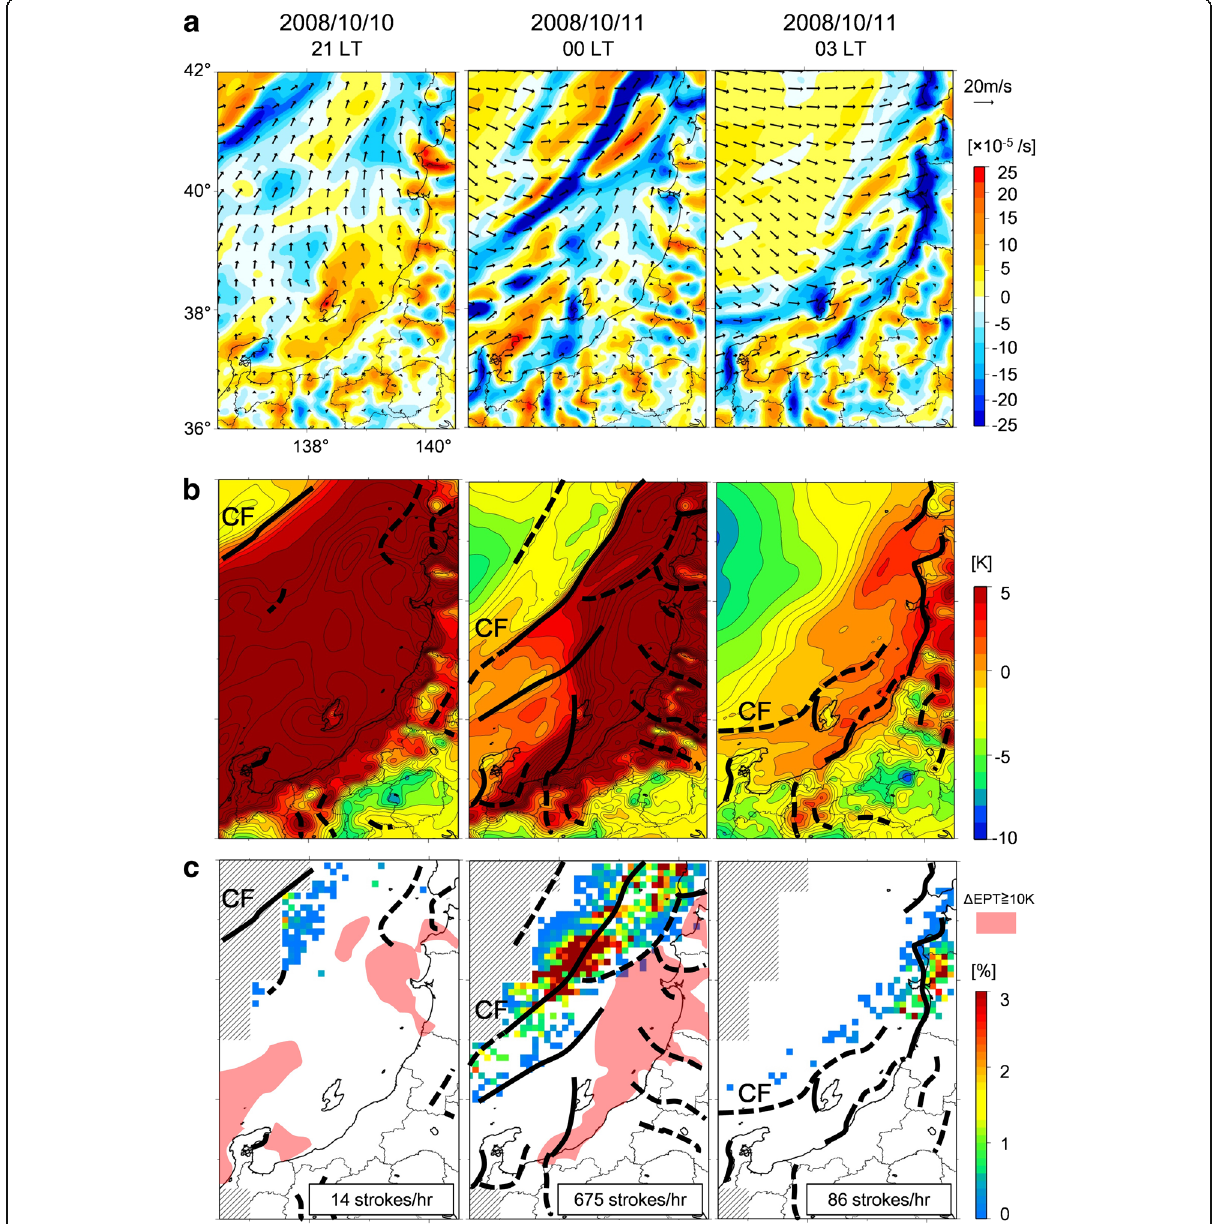
Fig. 11 Comparisons of divU and Δ EPT with lightning frequency distribution for case A. a Surface wind and divU distribution. b Δ EPT distribution and surface wind convergence lines. Strong wind convergence lines (divU ≤ − 20[×10 − 5 /s]) are shown as solid lines , while weak convergence lines ( − 20[×10 − 5 /s] < divU ≤ − 10[×10 − 5 /s]) are shown as dashed lines . c Composite maps of lightning frequency distribution, wind convergence lines, and regions where Δ EPT exceeds 10 K ( highlighted in pink